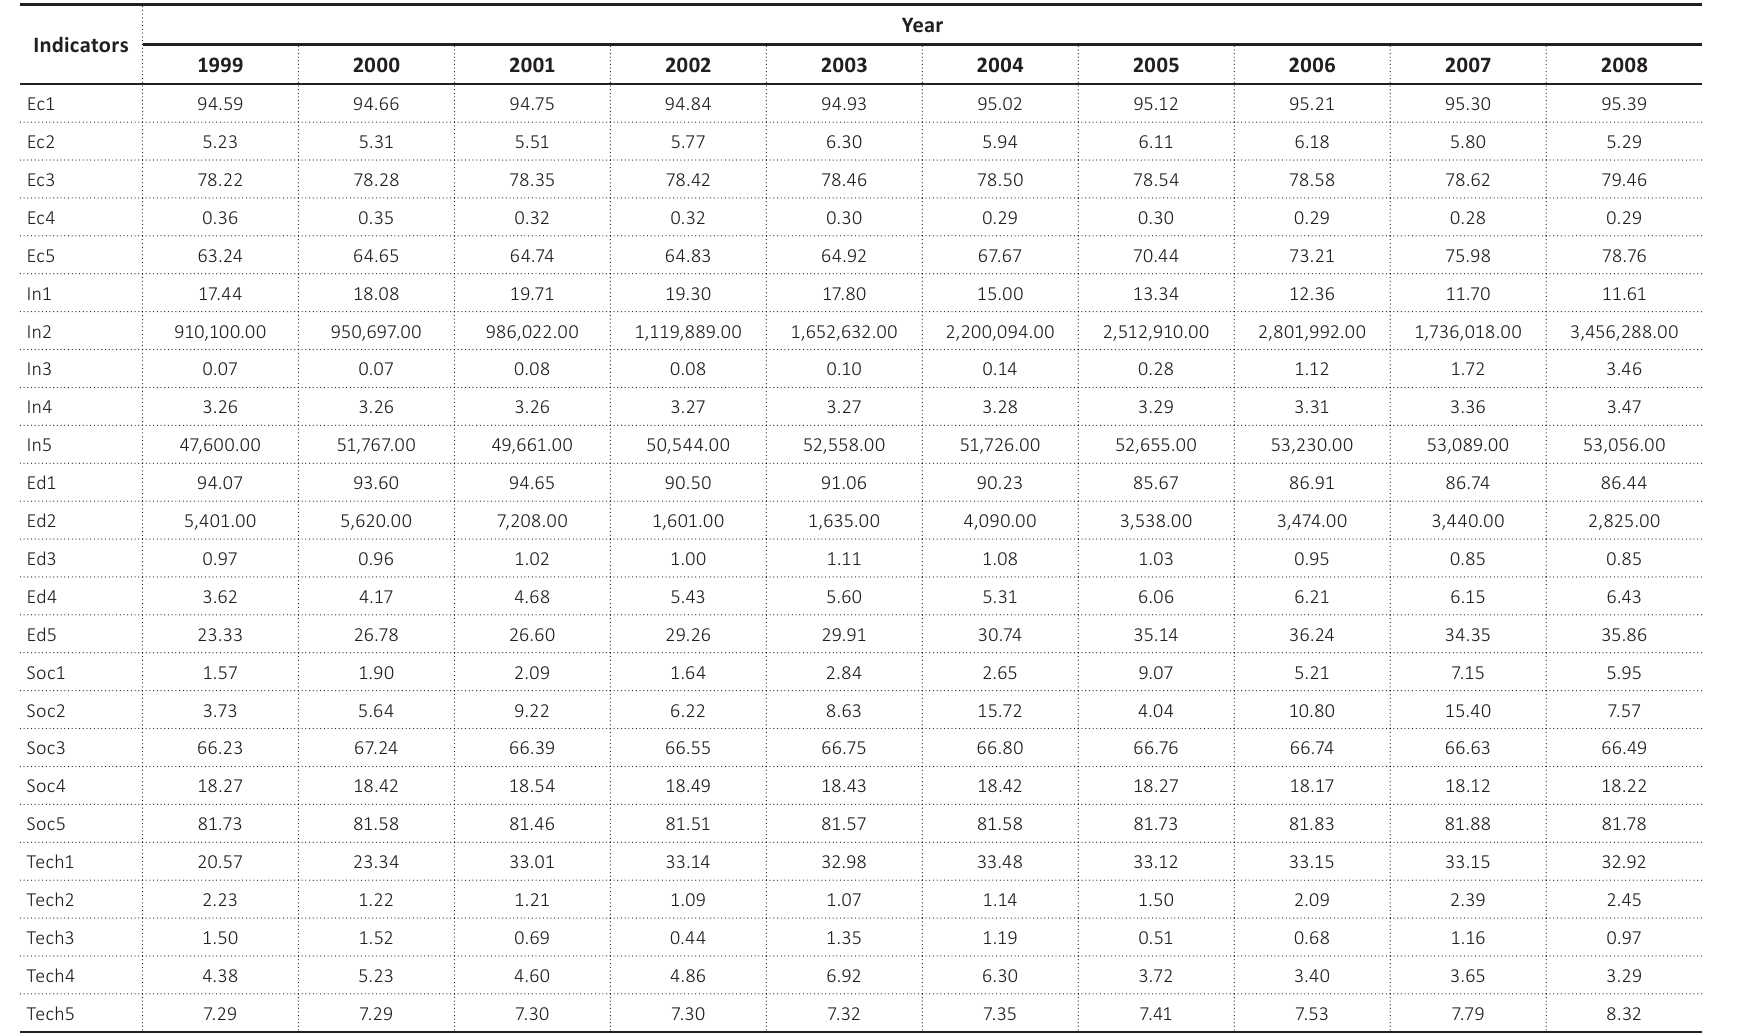
Table A1. Information base for the study of investment potential of Ukraine in